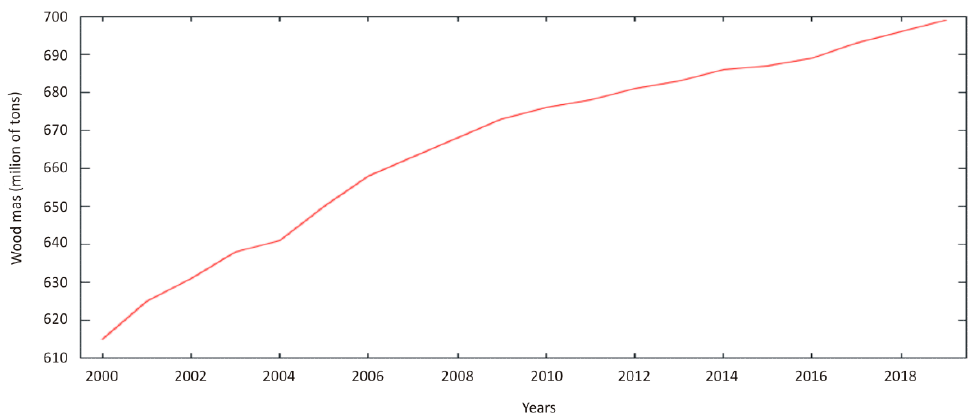
Figure 5. Total volume of both deciduous and coniferous wood mass in millions of tons for the years 2000 to 2019.